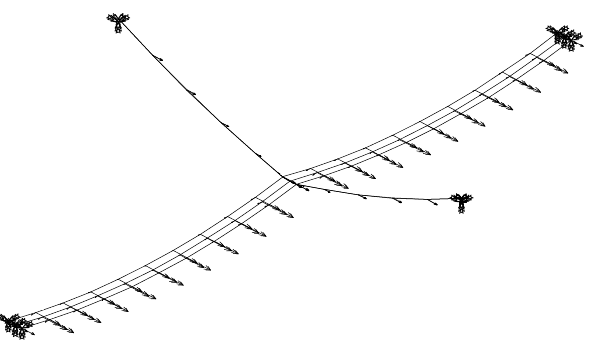
Figure 11. Diagram of wind loading (in 2 spans).